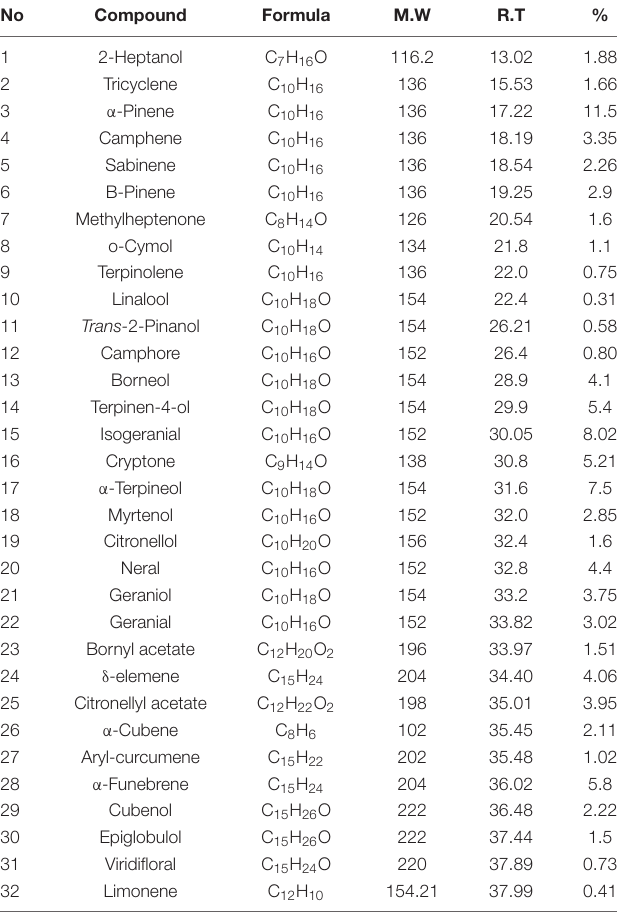
TABLE 1 | Major compounds identified in the lemon and ginger combination extract using GC-MS/MS